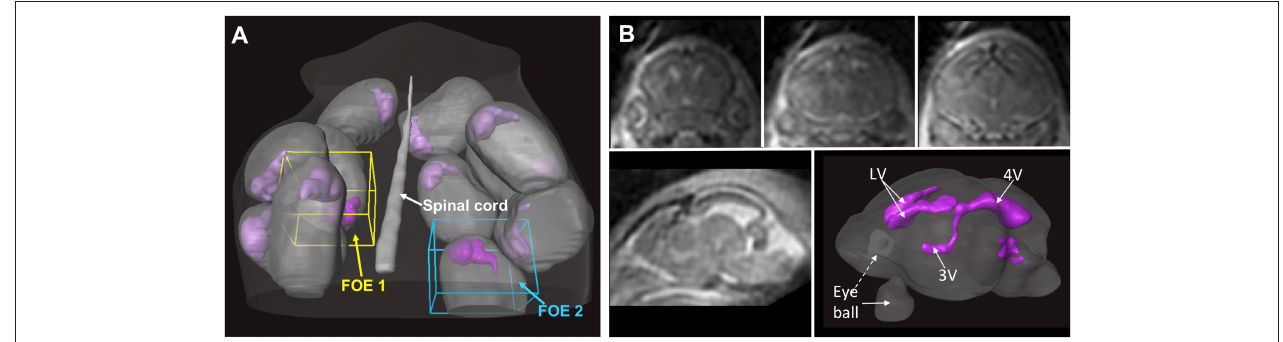
FIGURE 2 | In utero T 2 -weighted MRI of an embryonic mouse brain using the localized imaging approach. (A) Distributions of embryonic sacs (gray structures) and embryonic mouse brains (purple structures) in a pregnant mouse based on whole abdomen multi-slice T 2 -weighted images. Two localized fields of excitation (FOEs) are defined in the whole-abdomen image. (B) Coronal (top row) and sagittal (bottom left) T 2 -weighted images of a mouse embryo acquired from one of the localized FOEs. The imaging resolution is 0.12 mm isotropic. The ventricular system (purple structures in the bottom right image) in the embryonic mouse brain can be reconstructed based on the T 2 -weighted images. The images in this figure are modified from Wu et al. (2015) with permission.